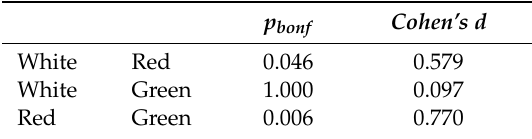
Table 10. Post hoc comparisons analyzing the text